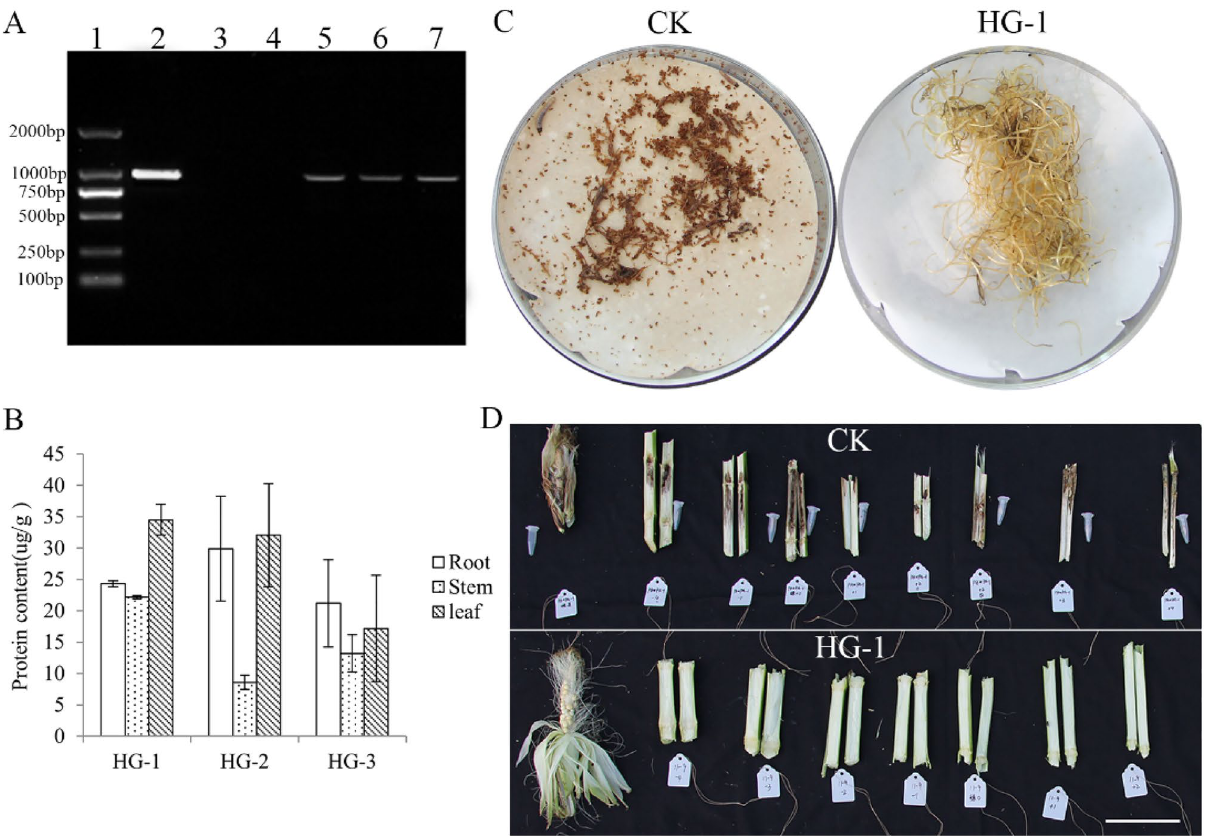
Figure 3. Expression and insect resistance analysis of Cry1Ab-Gc protein in maize. (A ) PCR analysis of maize genomic DNA. 1: DL 2000 Marker; 2: Plasmid positive control; 3: Black control; 4: Negative Control; 5: Transgenic event HG-1; 6: Transgenic event HG-2; 7: Transgenic event HG-3. ( B ) ELISA of Cry1Ab-Gc protein in three transgenic lines. ( C ) Insect resistance performance of maize filament in laboratory. ( D ) Insect resistance performance of maize in field. Scale bar, 10 cm.